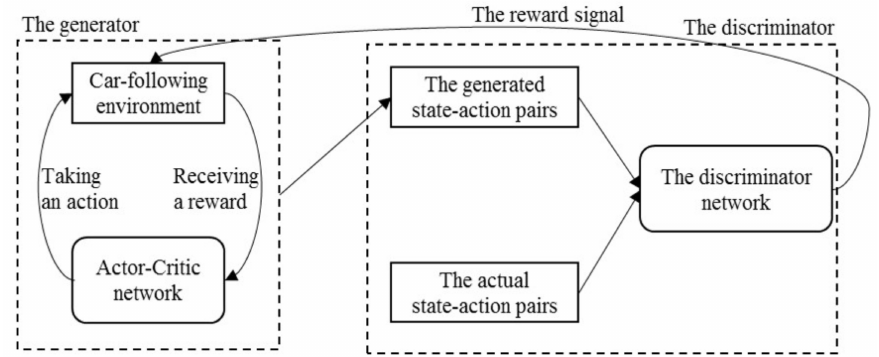
Figure 1. The structure of the proposed model generative adversarial imitation learning-gated recurrent unit (GAIL-GRU).